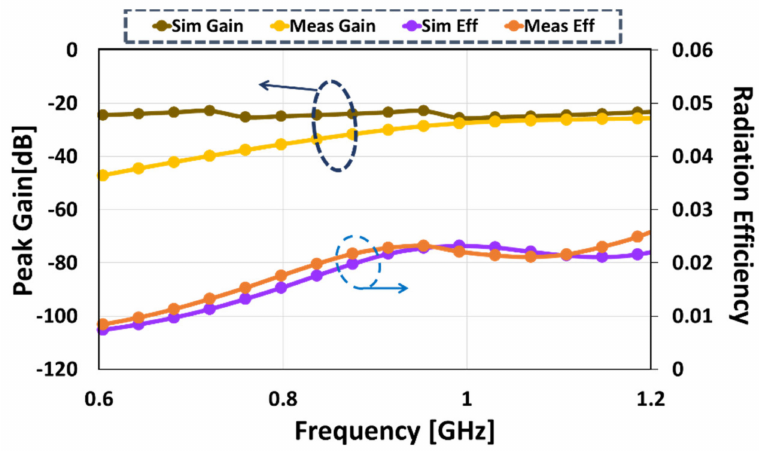
Figure 11. Simulated and measured gain and radiation efficiency inside